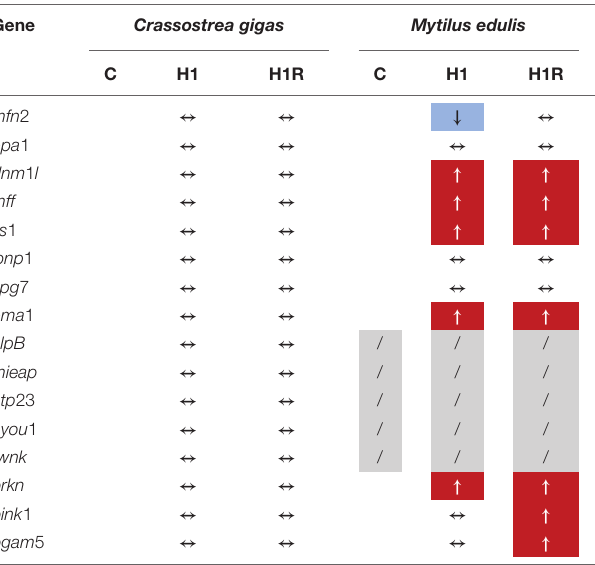
Red fields with upward arrows show upregulated mRNA expression, while blue fields with downward arrows show downregulated mRNA expression (compared to the normoxic baseline). Horizontal arrows – no change. Gray diagonally crossed fields – no data available. Exposure groups: C, normoxia (21% O 2 ); H1, 24 h hypoxia ( < 0.01% O 2 ); and H1R, 24 h hypoxia with subsequent 1.5 h reoxygenation ( < 0.01% to 21% O 2 ). Gene abbreviations: mfn2, mitofusin 2; opa1,